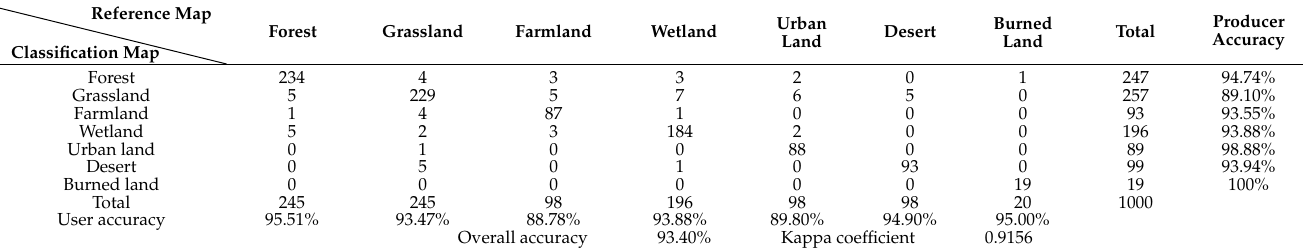
Table A2. Error matrix of land cover classification in 2010.